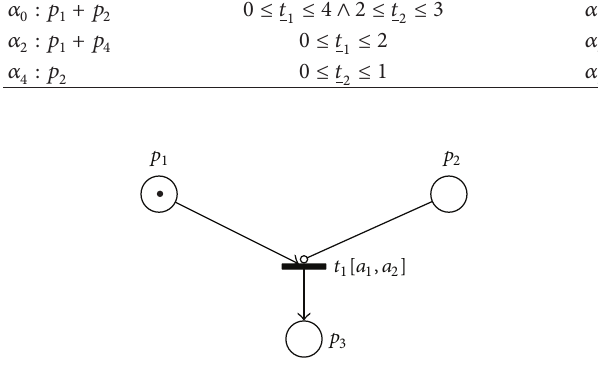
Figure 3: A simple example of time Petri nets with inhibitor hyperarc. 𝑡 1 is active if 𝑝 2 is not marked, otherwise it is suspended.